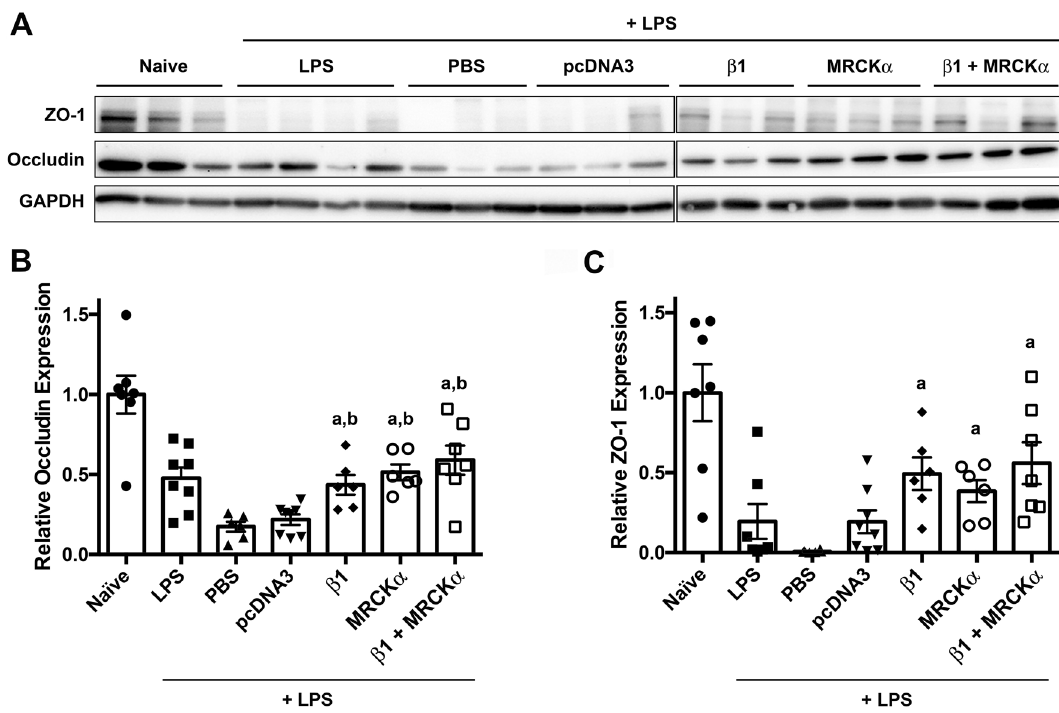
Figure 3. Overexpression of MRCKα restores ZO-1 and occludin expression in previously injured mouse lungs. Lung injury was established in C57B6 mice (n = 6–8) by aspiration of LPS (5 mg/kg) and 1 day later plasmids (100 µg each) expressing either no insert (pcDNA3), the β1 subunit of the Na + ,K + -ATPase (β1), MRCKα, or β1 and MRCKα were delivered in 50 µl to the lungs by aspiration followed immediately by electroporation (8 pulses of 10 ms duration each and 200 V/cm). Two days later (3 days after LPS administration), lungs were perfused with PBS and lysates were prepared for analysis by Western Blot ( A ). Levels of expression were normalized to GAPDH as a loading control and the relative expression of Occludin ( B ) and ZO-1 ( C ) are shown as mean ± SEM. All experiments were carried out three times and representative experiments are shown. One-way ANOVA with post-hoc Tukey’s multiple comparisons was used for statistical analysis; a, p < 0.05 compared to naïve; b, p < 0.05 compared to